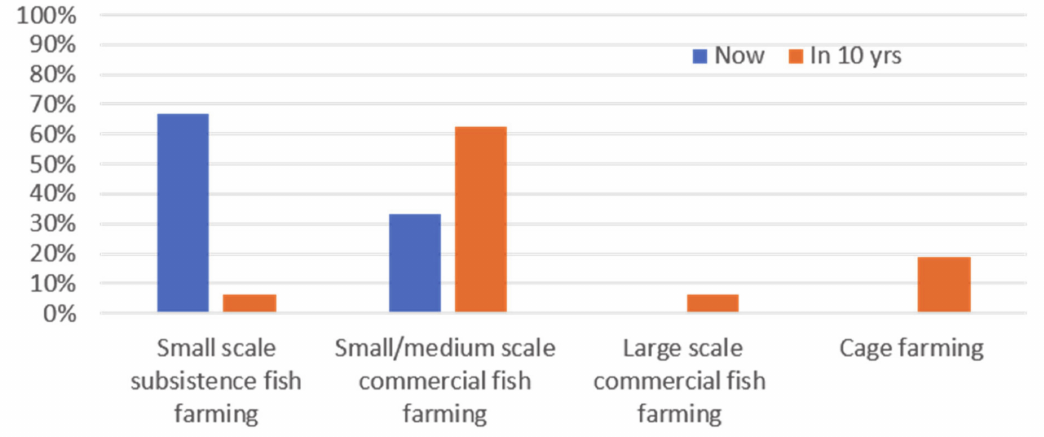
Figure 12. Regional fisheries officers perception of the dominant aquaculture system in their region now and in the 10-years time in